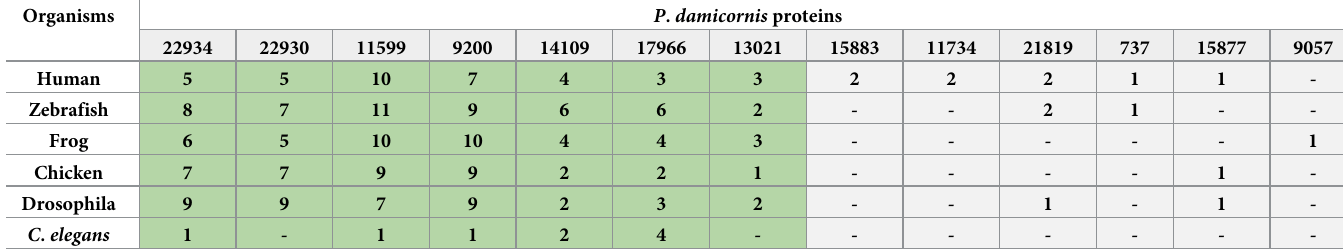
Table 1. Number of times a model organism shows homology to a given P . damicornis protein with 100% probability. Columns highlighted in green show at least one representation in each model organism studied. Organisms